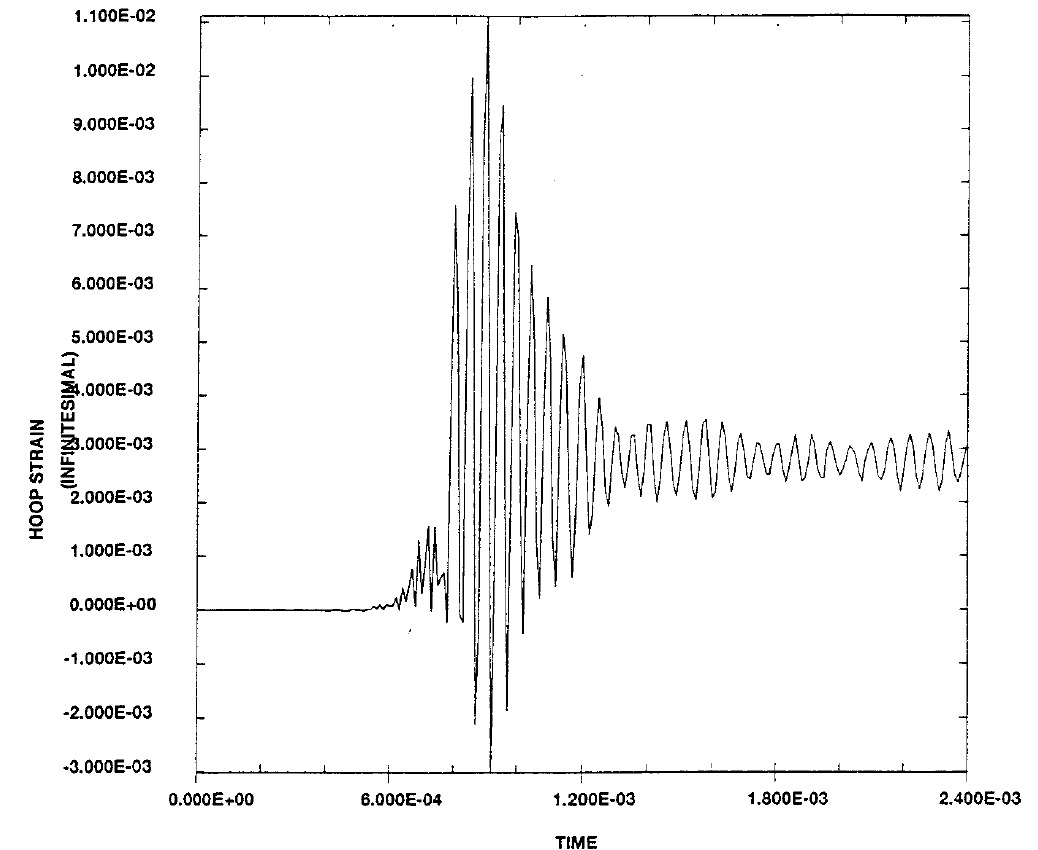
Fig. 7. Hoop strain in an element near the